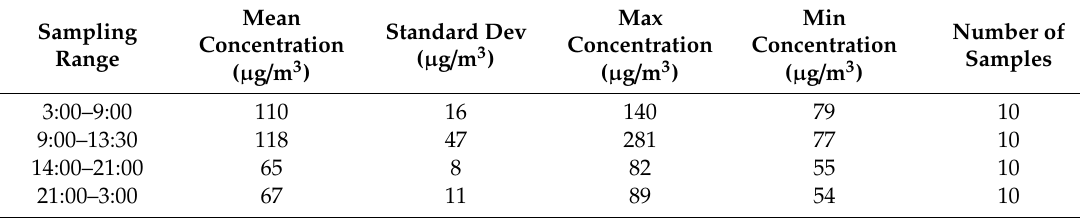
Table 1. PM 2.5 mean concentrations for each sampling